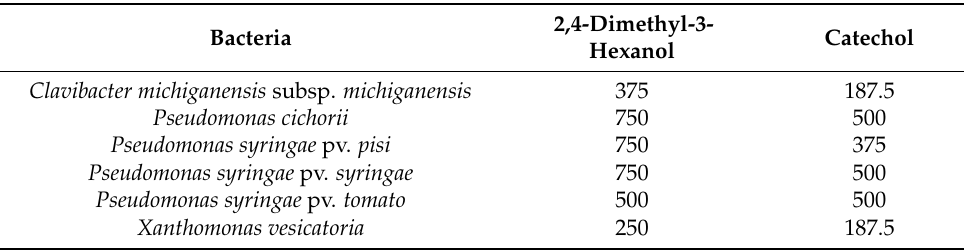
Table 2. Minimum inhibitory concentrations (expressed in µ g · mL − 1 ) of two G. biloba extract phyto- constituents against the horticultural pathogens.